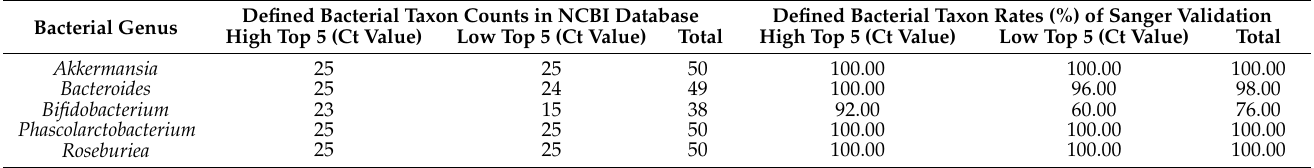
Table 4. Bacterial identification result by Sanger